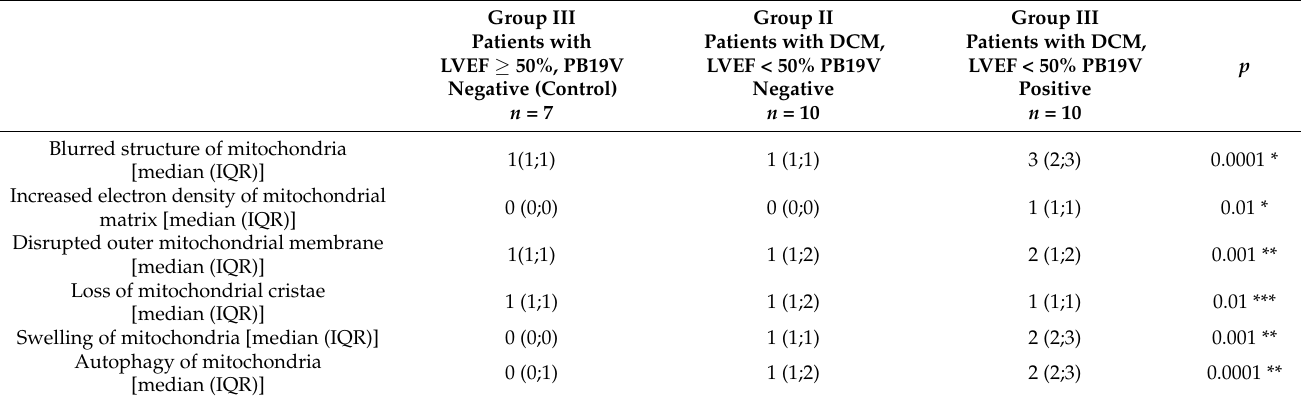
Figure 1. Electron microscopy images. Ultrastructural features of heart biopsies from patients with EF ≥ 50% and no virus detected. ( A ) Loss of mitochondrial cristae marked with black arrows; disrupted outer mitochondrial membrane marked with red arrow. ( B ) No features of necrosis; hypertrophic endothelium marked with an asterisk. Table 2. Ultrastructural changes in the mitochondria in patients with DCM and PB19V in myocardial